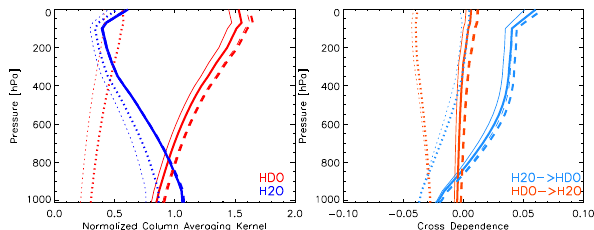
Fig. 3. Column averaging kernel of the H 2 O and HDO retrievals (left) and cross dependence between the H 2 O and HDO retrievals given by the non-diagonal elements of the averaging kernel matrix (right). The solid lines are for conifer, dashed lines for desert and the dotted lines for 5% albedo. The thick line is for SZA of 30 ◦ and the thin line for 60 ◦ . Fig. 4. The top panel gives errors in the HDO (left) and H 2 O (right) retrieval for the sensitivity tests for temperature (Temp), surface pressure (Press), aerosol (Aero), cirrus cloud (Cirrus) and the a priori HDO/H 2 O ratio (Ratio) and the shape of the H 2 O and HDO a priori profiles (Profile). The bottom panel gives the error in δ D in ‰ (left) and relative to the estimated random error (right). The colour denotes the surface type (blue = 5% albedo; green = conifer; red = desert), the symbol the SZA (circle = 30 ◦ ; triangle = 60 ◦ ), and open symbols are for the winter atmosphere and filled symbols for the summer